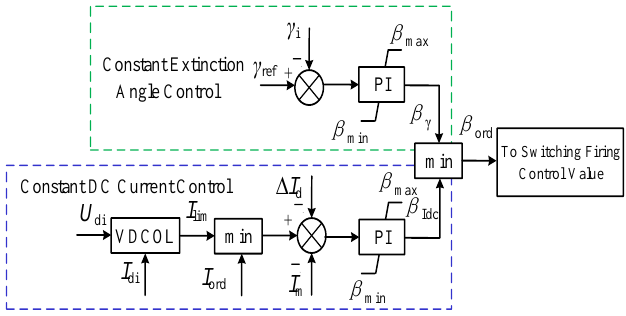
Fig. 1. Schematic diagram of multi-infeed HVDC topology